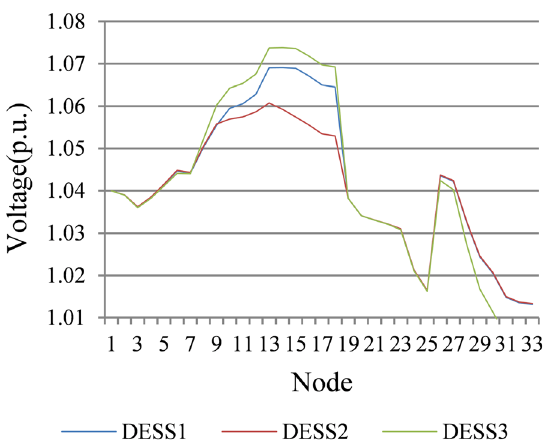
Fig. 8 Voltage profile of different DESS with rating output power at14:00